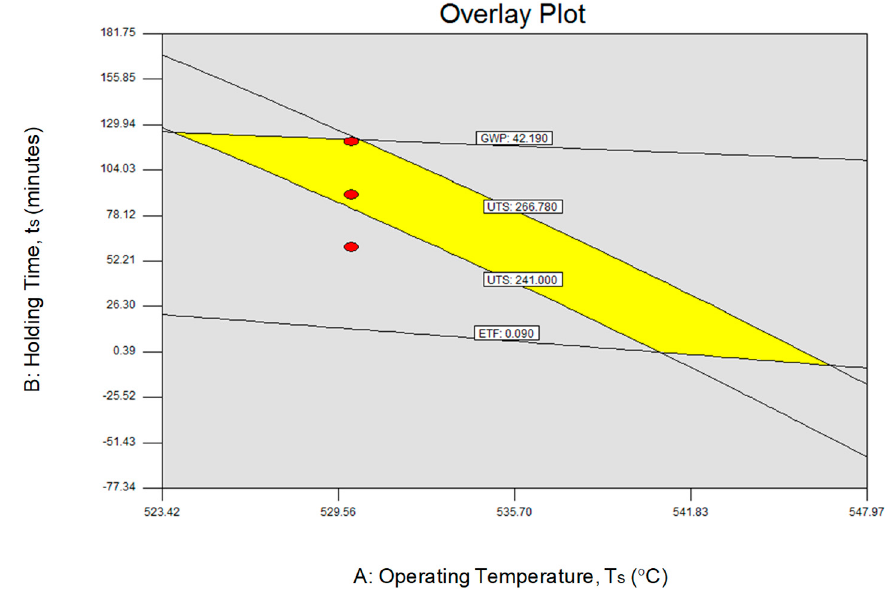
Figure 9. Overlay plot for optimization.